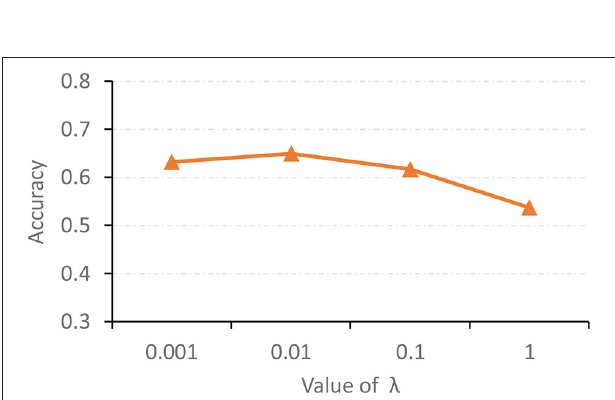
and report the corresponding results of AMNI in Table 5